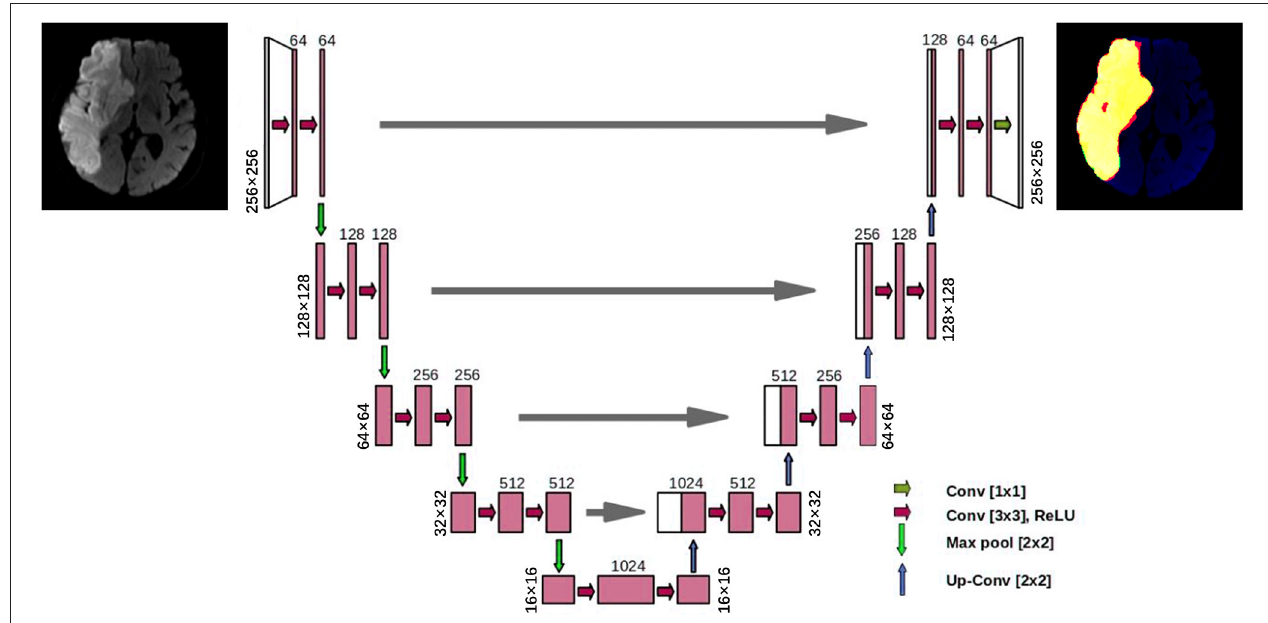
FIGURE 2 | The architecture of the proposed U-net